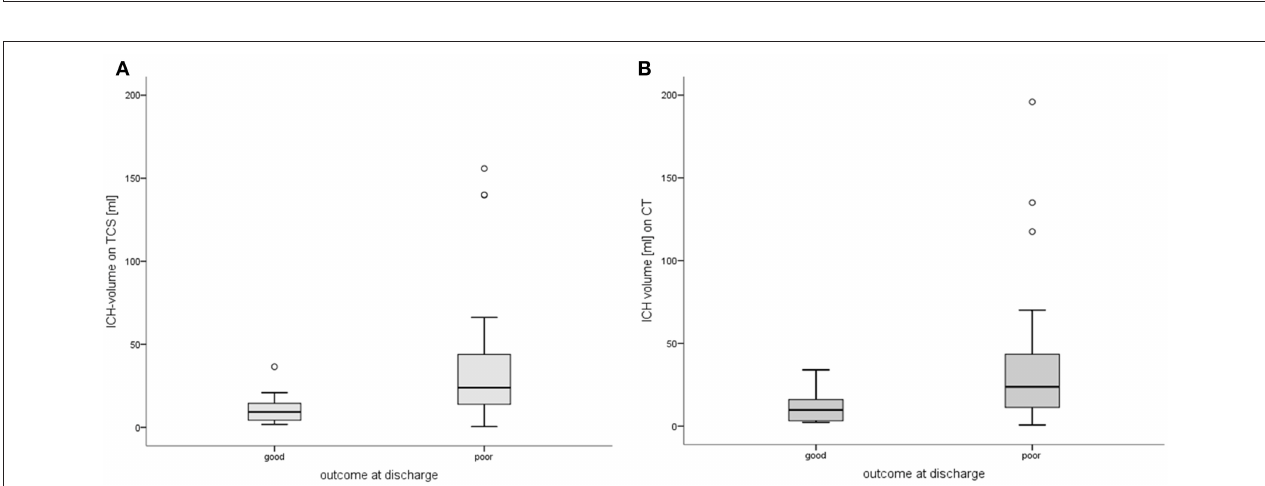
FIGURE 3 | Volumes of intracerebral hemorrhages in patients with good vs. poor outcome. (A) Comparing patients with good vs. poor outcome based on TCS-volumetry ( p = 0.002). (B) Comparing patients with good vs. poor outcome based on CT-volumetry ( p = 0.013). Significant differences of ICH-volumetry in patients with a good (mRS 0-3) vs. poor (mRS 4-6) outcome at discharge. ◦ indicating outliers with discordant volumetric values. CT, computed tomography; ICH, intracerebral hemorrhage; mRS, modified Rankin Scale; TCS, transcranial sonography.